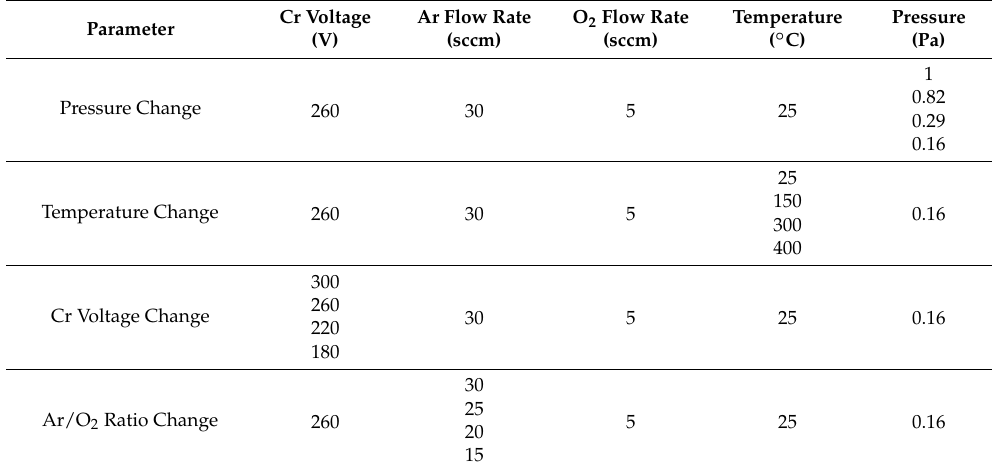
Table 1. Detailed deposition parameters for the deposition of chromium oxide